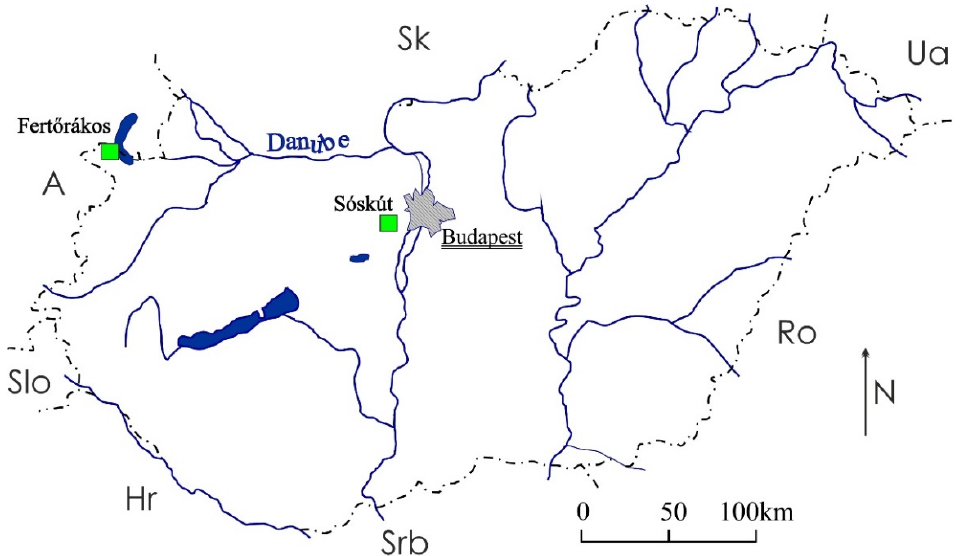
Figure 2. Locations of the limestone quarries, Fert ő rákos and Sóskút (marked in green squares).